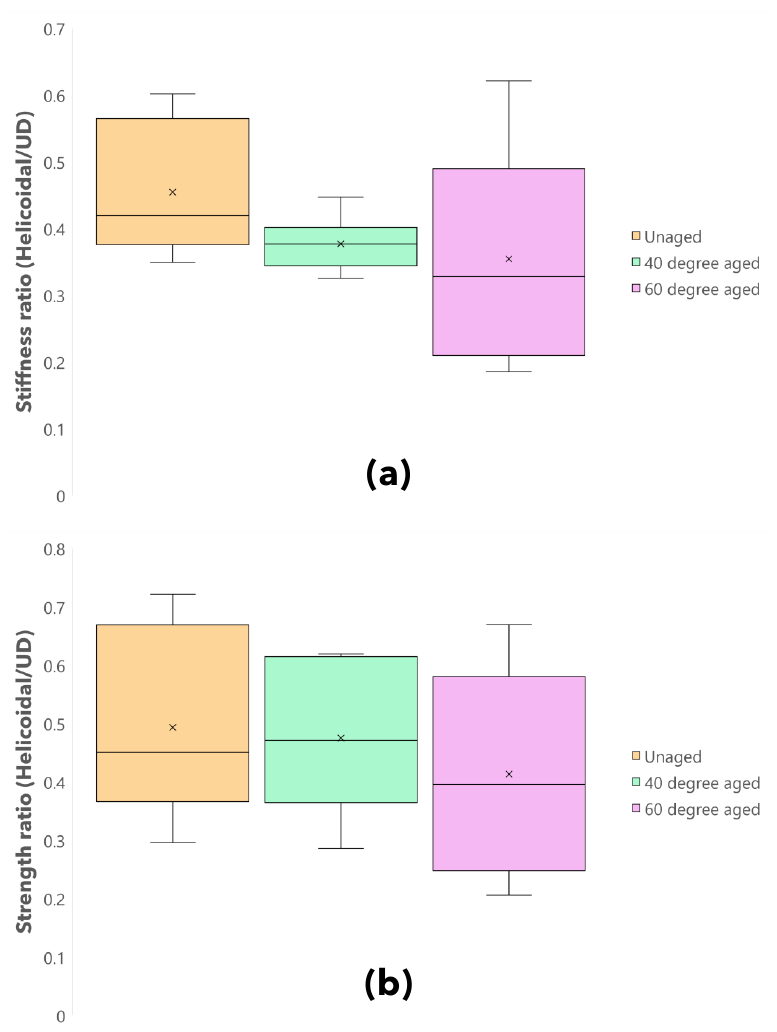
Figure 4. Box and whisker plot of ( a ) the stiffness ratio and ( b ) the strength ratio of helicoidal composites to UD composites subjected to the same conditioning: unaged, 40 ◦ C ageing, and 60 ◦ C